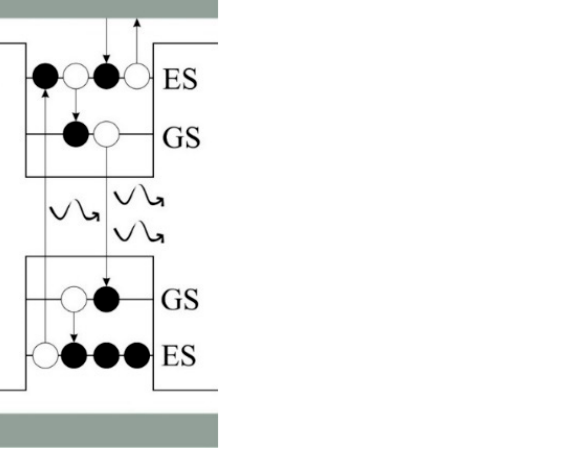
Figure 1. Energy band diagram for the proposed QD structure. This figure shows possible transitions between states that are considered in the rate equations.